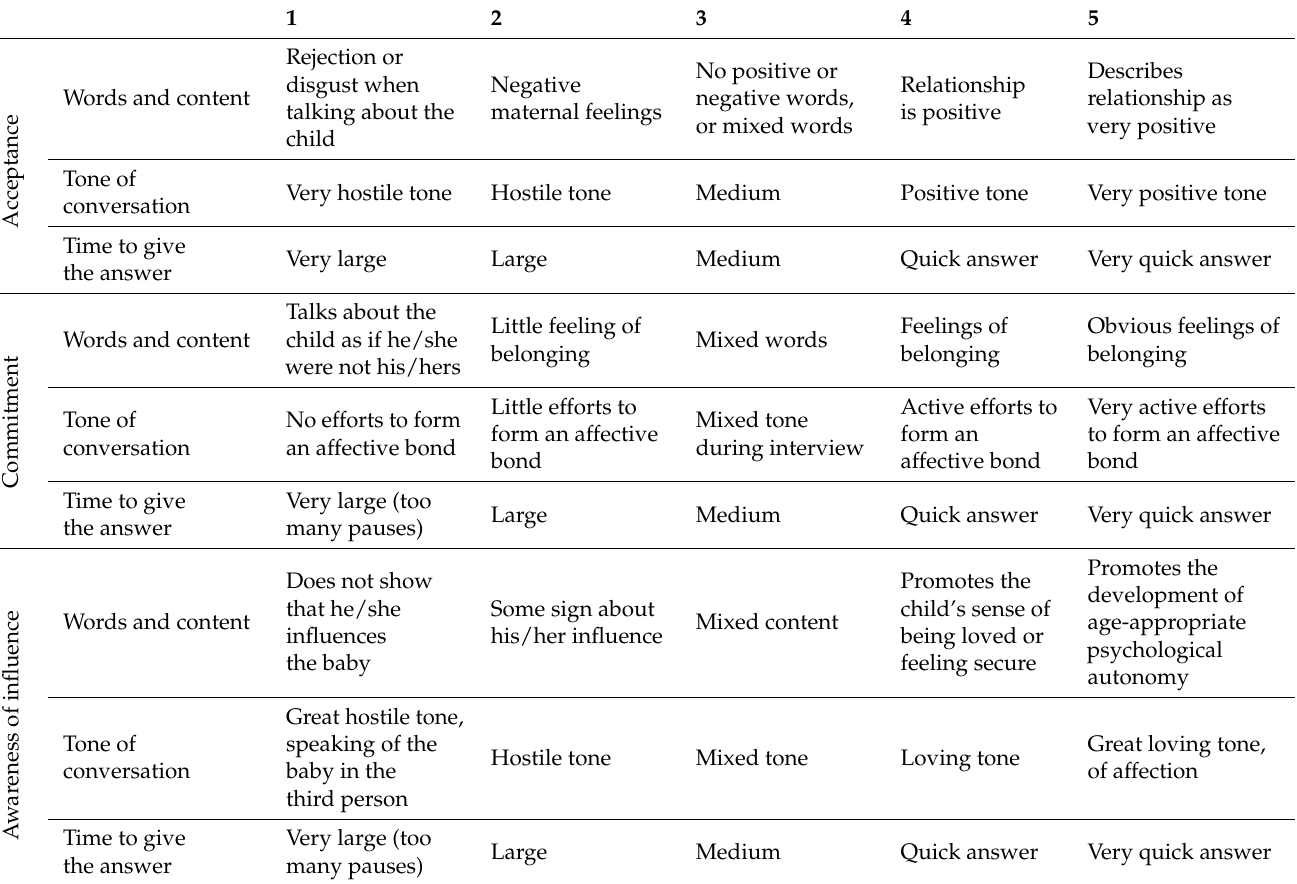
Table 1. Rubric to code the parents’ responses on the Likert scale for the indices of acceptance, commitment and awareness of